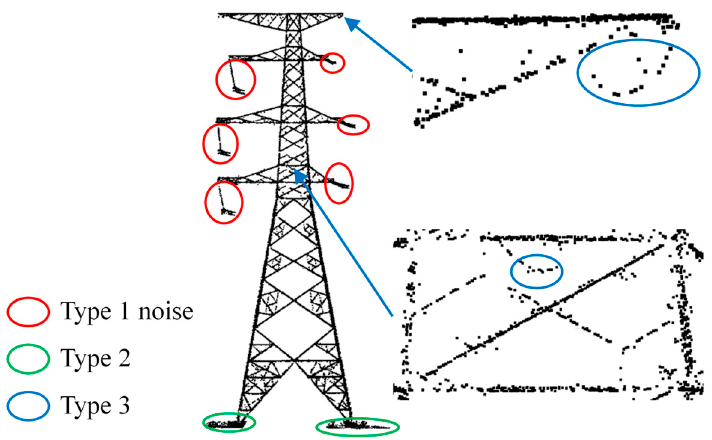
Figure 25. Pylon points with noise.